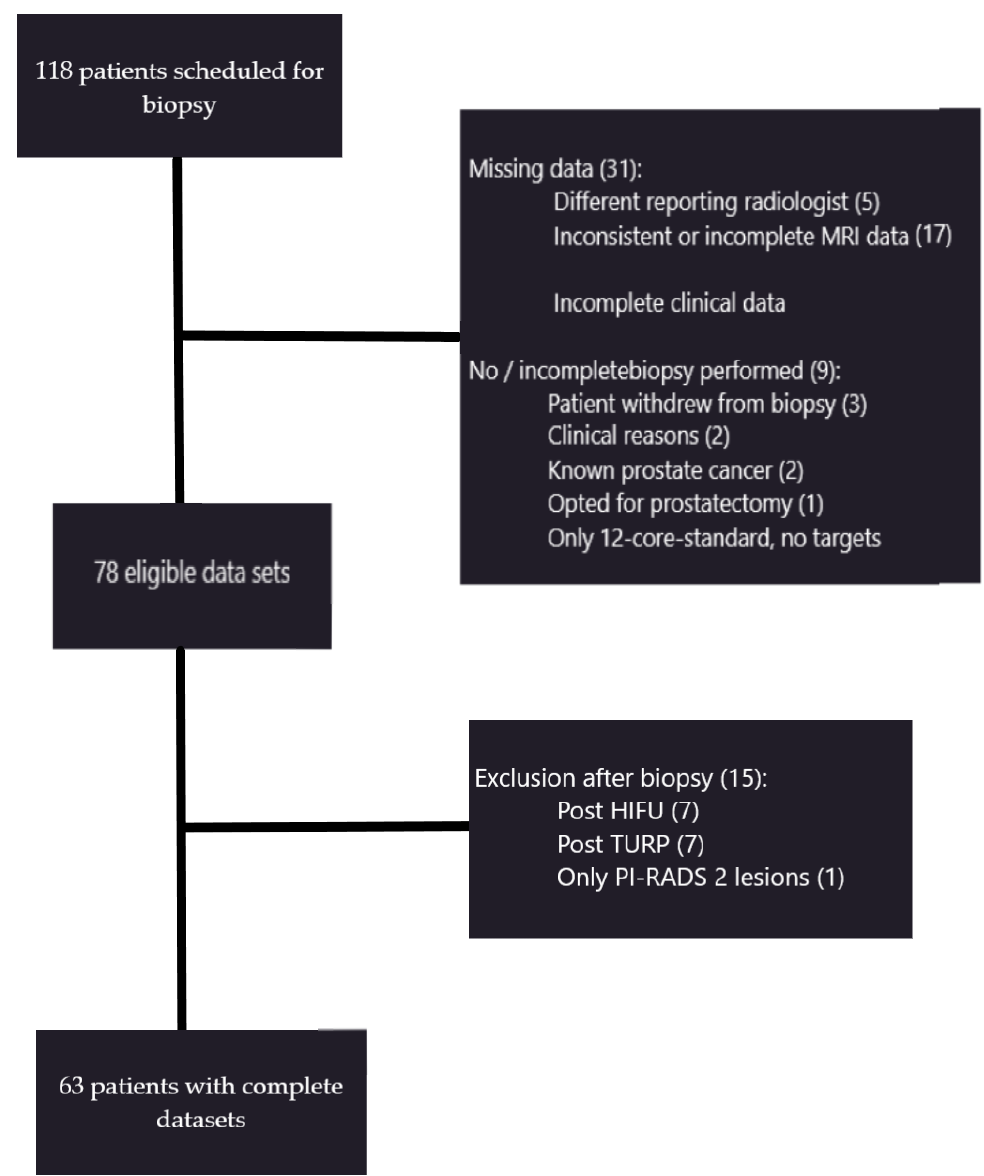
Figure 1. Our patient cohort and exclusion criteria compiled according to individual reasons. Of the initial 118 patients, 63 patients were included in the final evaluation. PI-RADS, Prostate Imaging Reporting and Data System; HIFU, High-intensity focused Ultrasound; TURP, Transurethral resection of the